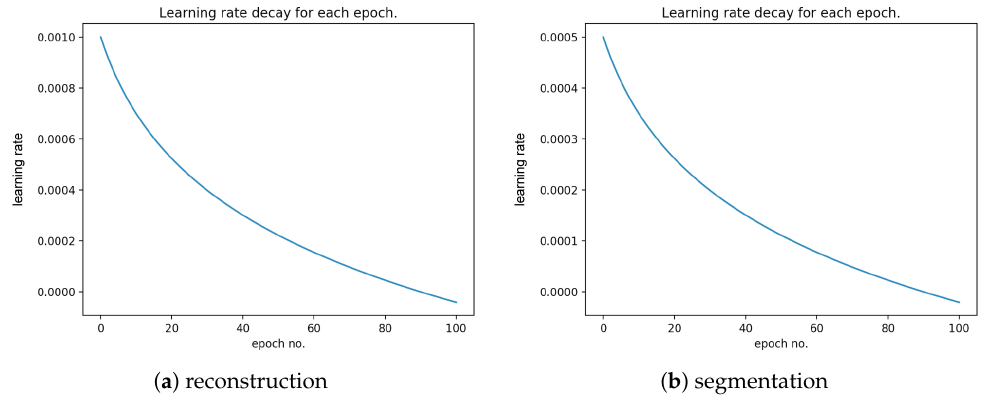
Figure 11. Learning rate decay for each epoch for ( a ) reconstruction and ( b ) segmentation over the training and validation